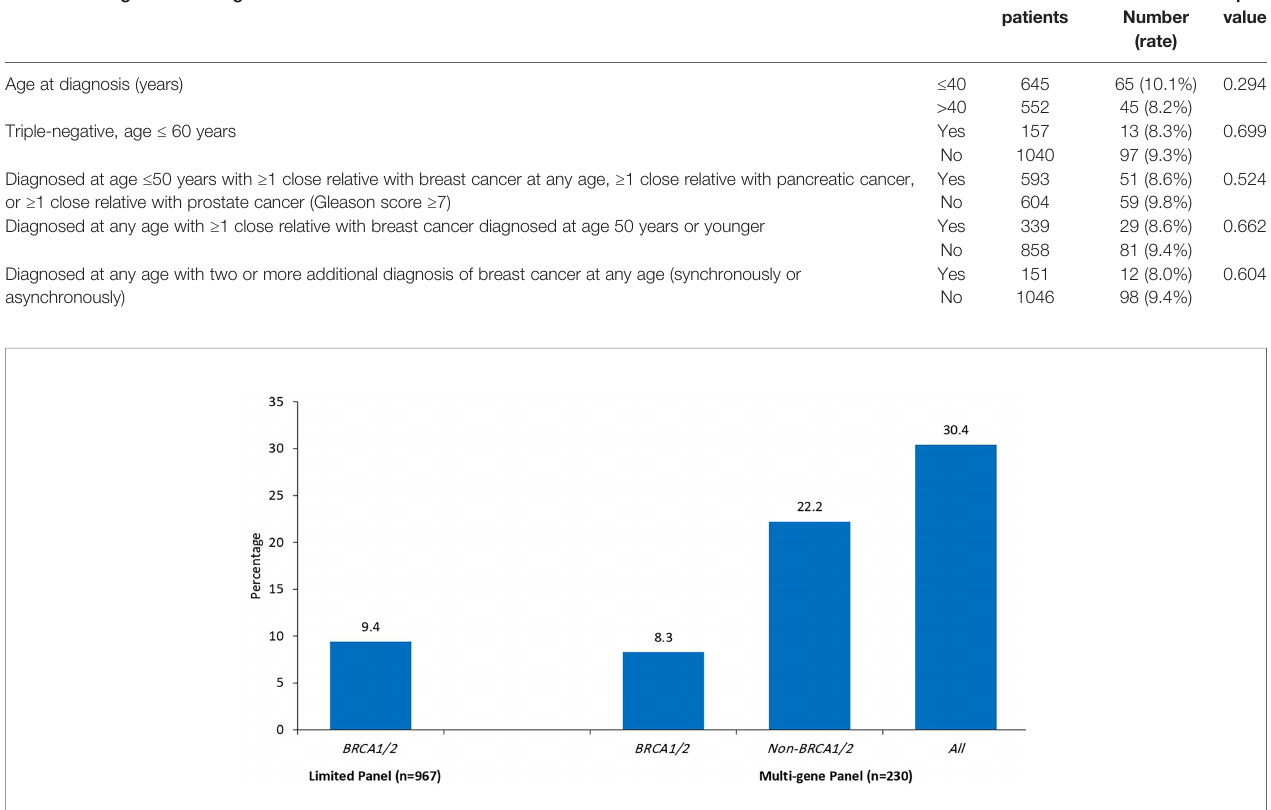
FIGURE 1 | Rates of Variants of Uncertain Signi fi cance (VUS) by testing panel (n = 1197).